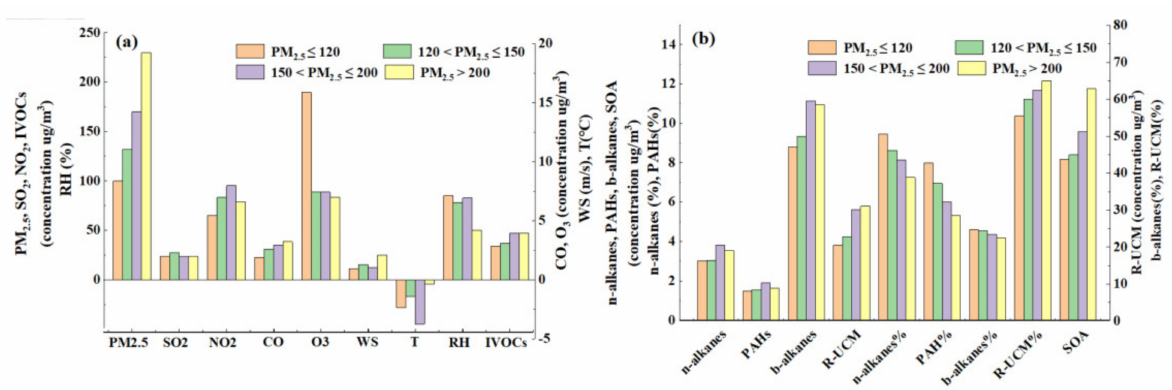
Figure 2. Characteristics of gaseous precursors, IVOCs components, and contribution to SOA at different pollution stages. ( a ) The concentration of PM 2.5 , IVOCs, SO 2 , NO 2 , CO, and O 3 and meteorological parameters such as WS, RH, and T; ( b ) the concentration of n -alkanes, PAHs, b -alkanes, R-UCM, and SOA, and the corresponding ratios in